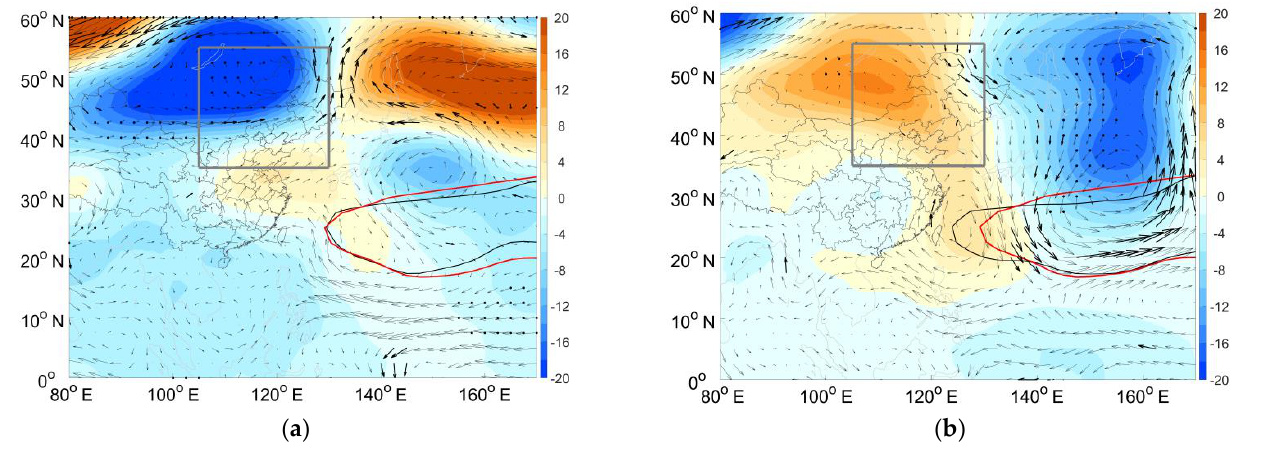
Figure 4. For the typical ( a ) high-NPP and ( b ) low-NPP years, geopotential height anomaly field of 500 hPa in summer (in shadow, unit: GPM; dot: α = 0.05 reliability test), 5880 characteristic isoline mean field (black isoline, unit: GPM), 5880 characteristic isoline climatological mean field (red isoline, unit: GPM) and the 850 hPa of the wind vector anomaly field (arrow, unit: m·s − 1 ; thick arrow: α = 0.05 reliability test).